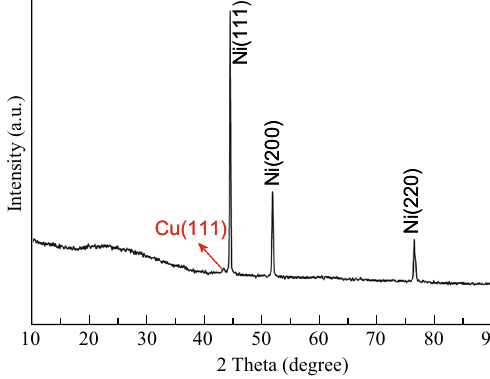
Fig. 3 Amperometric responses of CuNi/C obtained from different Cu depositing time, and the detail shows the consecutive addition of 20 μ M glucose into 0.1 M NaOH at 0.54 V Fig. 4 XRD pattern of CuNi/C